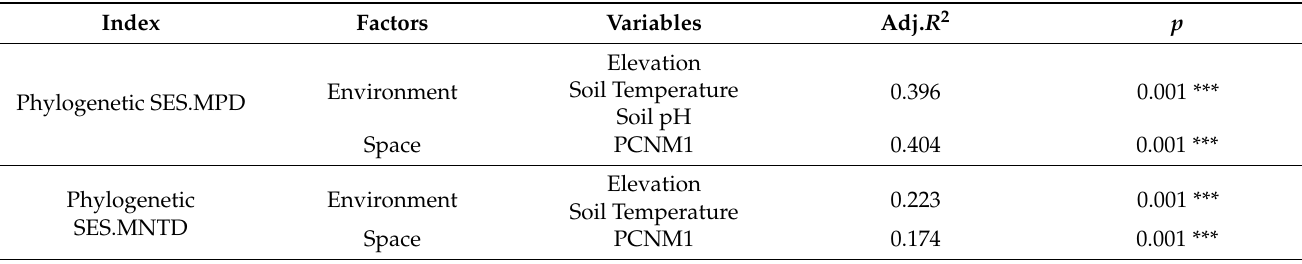
Table A4. Forward selection results of environmental factors and spatial